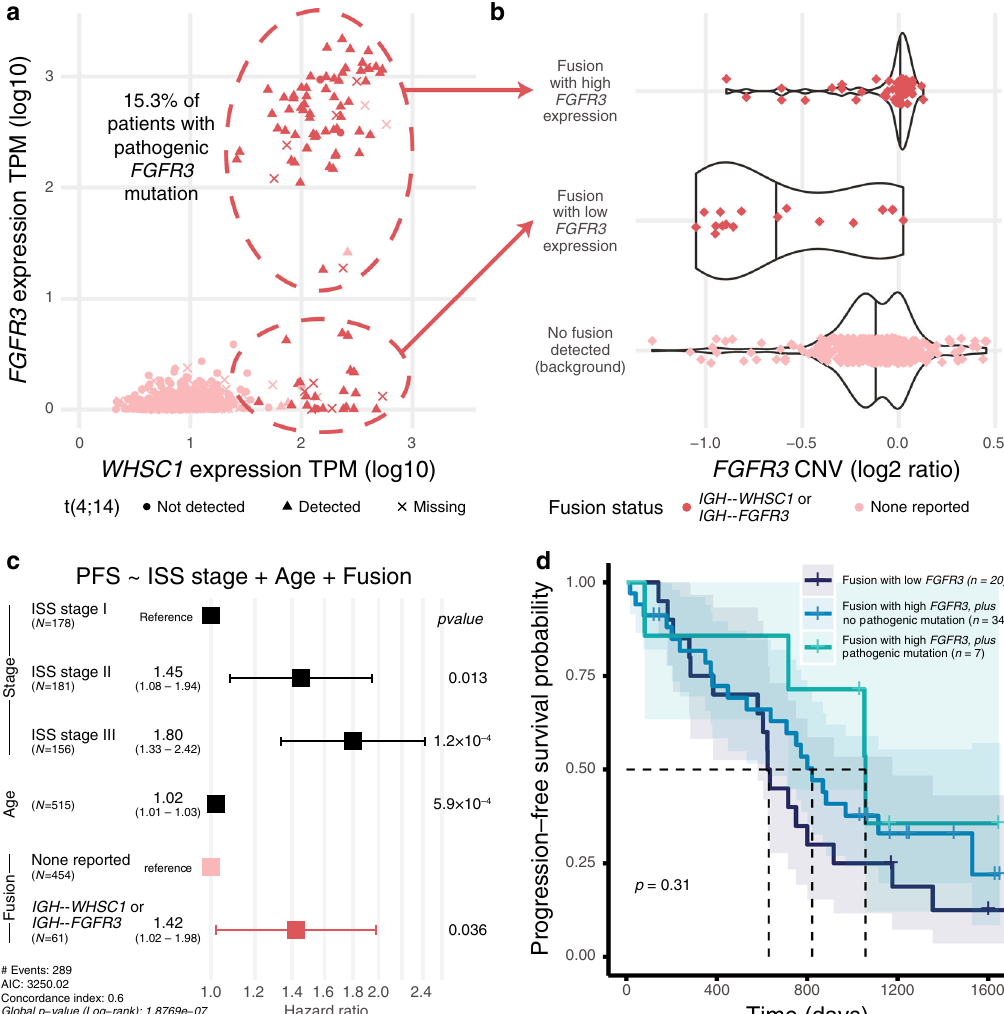
Fig. 5 t(4;14) WHSC1 and FGFR3 expression and survival patterns. a Coexpression of WHSC1 and FGFR3 , annotated with fusion and translocation status. b FGFR3 copy number (log2 of the tumor/normal ratio). Violin plots de fi ned as: Fusion with high FGFR3 expression ( n = 60, minimum = − 0.89, maximum = 0.127, median = 0.013); Fusion with low FGFR3 expression (18, − 1.05, 0.024, − 0.72); No fusion detected (background) (412, − 1.28, 0.45, − 0.13). All data points from 0 to 100th percentile are shown. c . Multivariate Cox proportional hazards progression-free survival model including disease stage, age, and fusion status. Error bars indicate a 95% con fi dence interval on each hazard ratio estimate. Covariate p values derived from z-scores are two-sided. d Kaplan – Meier curve strati fi ed by FGFR3 expression among fusion patients. Shaded regions indicate a 95% con fi dence interval on each survival curve. Signi fi cance p value was calculated by two-sided log-rank test and uncorrected for multiple comparisons. Source data and scripts are available at https://doi.org/10.6084/m9. fi Fig. 6a). Fusion samples with low FGFR3 expression had distinctly lower FGFR3 copy number (Fig. 5b) while corresponding WHSC1 copy number tended to remain neutral (Supplementary Fig. 6b),